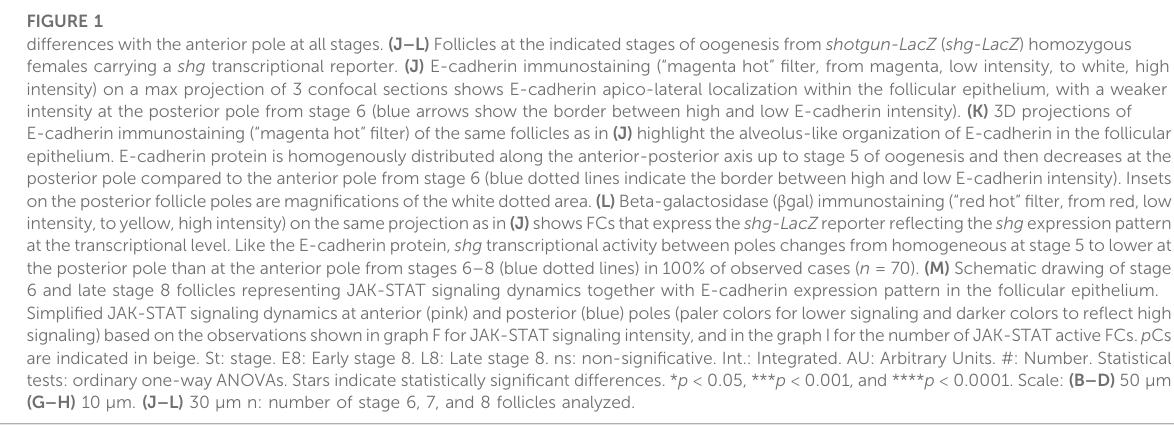
FIGURE 1 differences with the anterior pole at all stages. (J – L) Follicles at the indicated stages of oogenesis from shotgun-LacZ ( shg-LacZ ) homozygous females carrying a shg transcriptional reporter. (J) E-cadherin immunostaining ( “ magenta hot ” fi lter, from magenta, low intensity, to white, high intensity) on a max projection of 3 confocal sections shows E-cadherin apico-lateral localization within the follicular epithelium, with a weaker intensity at the posterior pole from stage 6 (blue arrows show the border between high and low E-cadherin intensity). (K) 3D projections of E-cadherin immunostaining ( “ magenta hot ” fi lter) of the same follicles as in (J) highlight the alveolus-like organization of E-cadherin in the follicular epithelium. E-cadherin protein is homogenously distributed along the anterior-posterior axis up to stage 5 of oogenesis and then decreases at the posterior pole compared to the anterior pole from stage 6 (blue dotted lines indicate the border between high and low E-cadherin intensity). Insets ontheposteriorfolliclepolesaremagni fi cationsofthewhitedottedarea. (L) Beta-galactosidase( β gal)immunostaining( “ redhot ” fi lter,fromred,low intensity,toyellow,highintensity)onthesameprojectionasin (J) showsFCsthatexpressthe shg-LacZ reporterre fl ectingthe shg expressionpattern atthetranscriptional level. Like theE-cadherinprotein, shg transcriptional activity between poleschanges from homogeneousatstage 5to lowerat the posterior pole than at the anterior pole from stages 6 – 8 (blue dotted lines) in 100% of observed cases ( n = 70). (M) Schematic drawing of stage 6 and late stage 8 follicles representing JAK-STAT signaling dynamics together with E-cadherin expression pattern in the follicular epithelium. Simpli fi ed JAK-STAT signaling dynamics at anterior (pink) and posterior (blue) poles (paler colors for lower signaling and darker colors to re fl ect high signaling)basedontheobservationsshowningraphFforJAK-STATsignalingintensity,andinthegraphIforthenumberofJAK-STATactiveFCs. p Cs are indicated in beige. St: stage. E8: Early stage 8. L8: Late stage 8. ns: non-signi fi cative. Int.: Integrated. AU: Arbitrary Units. #: Number. Statistical tests: ordinary one-way ANOVAs. Stars indicate statistically signi fi cant differences. * p < 0.05, *** p < 0.001, and **** p < 0.0001. Scale: (B – D) 50